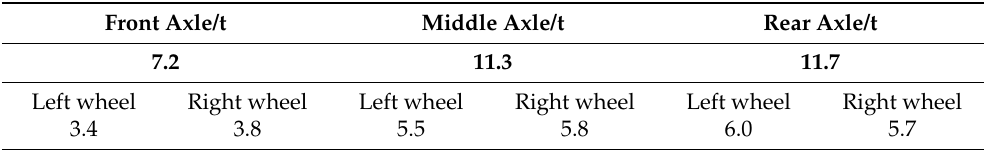
Figure 5. Truck information. ( a ) Picture of truck on bridge; ( b ) Truck configuration (Unit: mm). Table 1. Truck weight